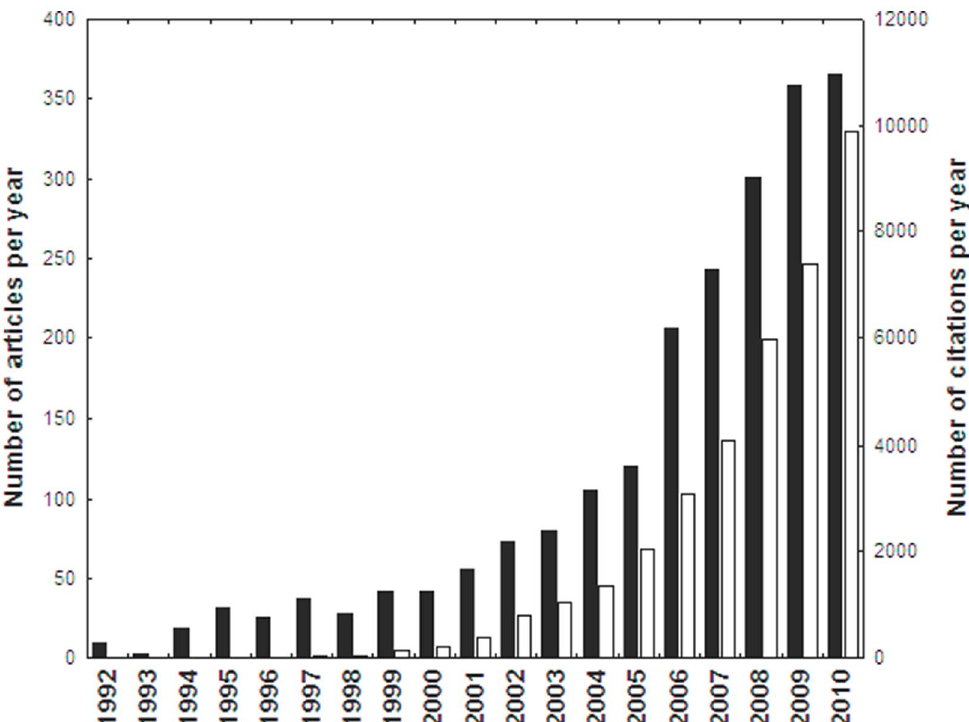
Figure 1. Number of published SDM related articles in the ecological literature (black bars) and number of citations received by these articles per year (white bars) during the period 1992–2010.